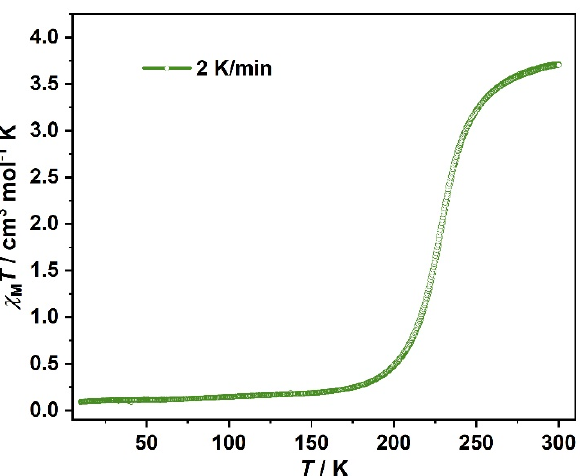
Figure 1. Temperature-dependent molar magnetic susceptibility, χ M T , products for 1 under 2 K/min sweeping rates.